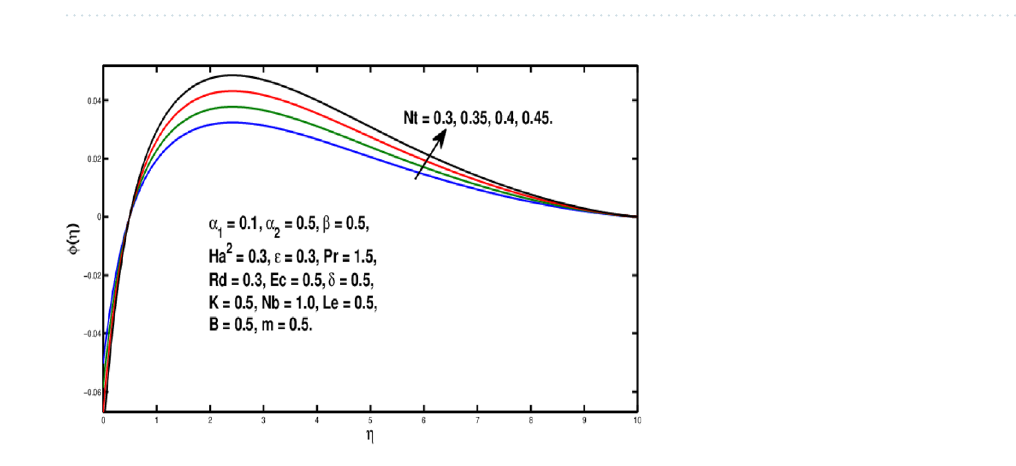
Figure 12. Variation of Nt on φ(η) .